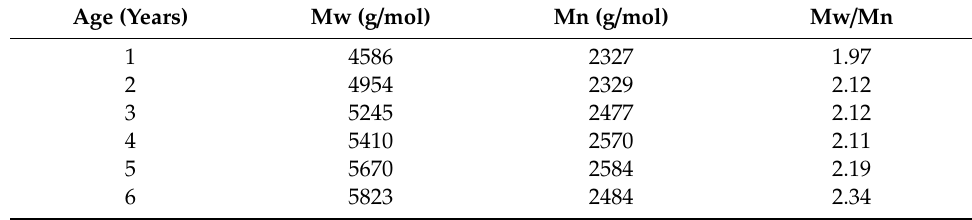
Table 1. Weight-average (Mw) and number-average (Mn) molecular weights and polydispersity (Mw/Mn) of 1–6 years old bamboo lignin samples.